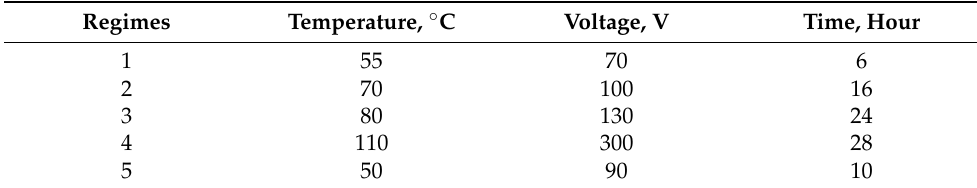
Table 1. Temperature and reverse bias voltage regimes.